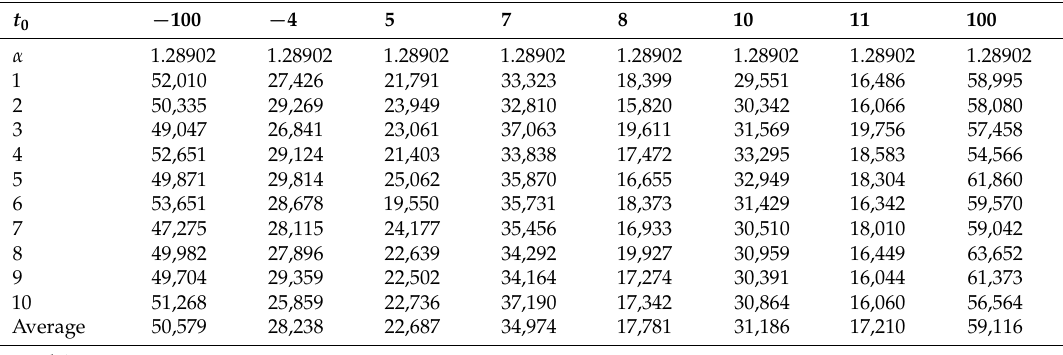
Table 11. Running time for different initial values of Example 5 by our method.